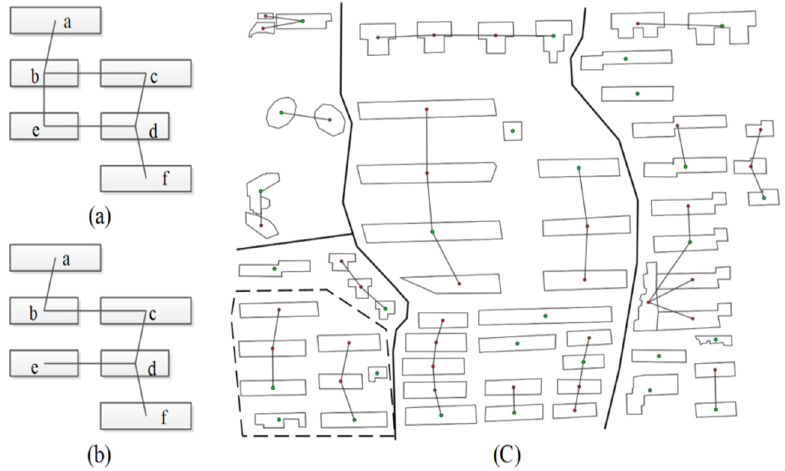
Figure 12. Linear detection: ( a ) preliminary proximity graph; ( b ) MST; ( c ) final graph.